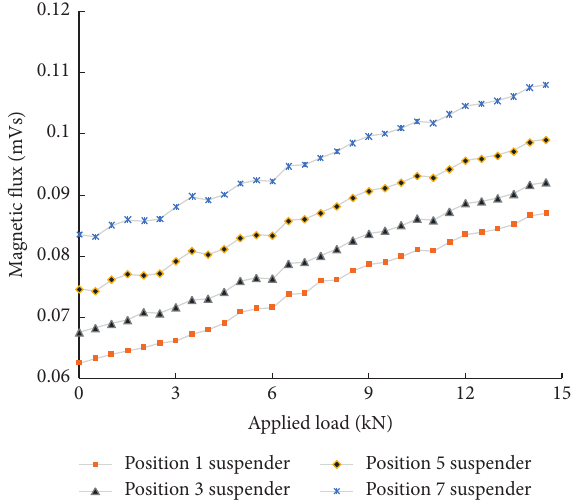
Figure 8: Induced magnetic flux at different hanger rod positions under the same